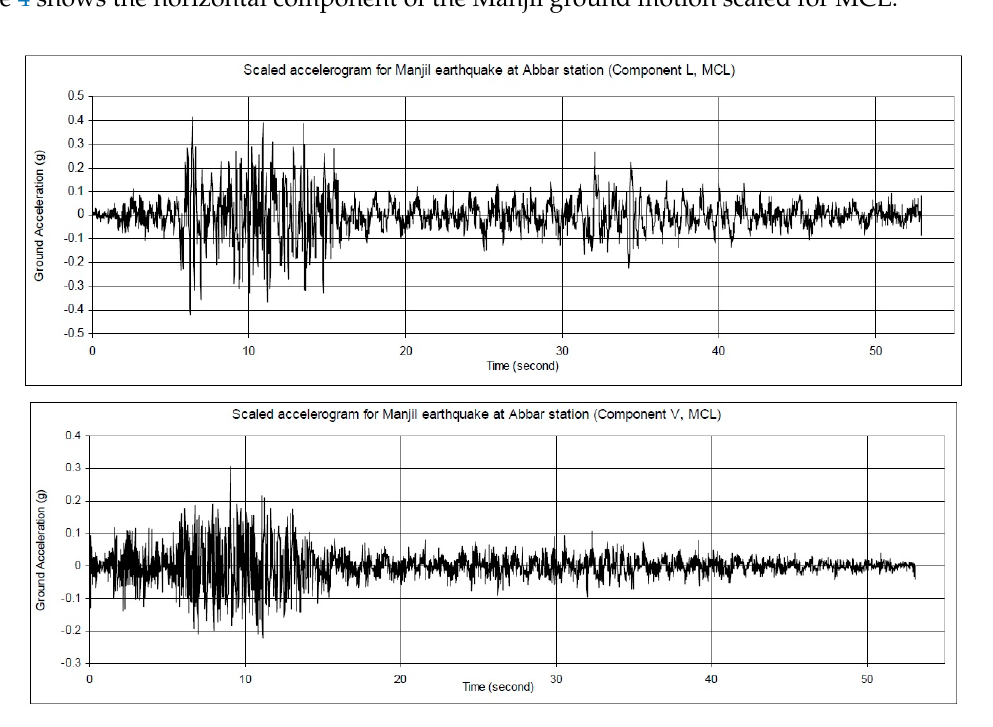
Figure 4. Scaled Manijl ground motion recorded at Abbar station (horizontal component L and vertical component